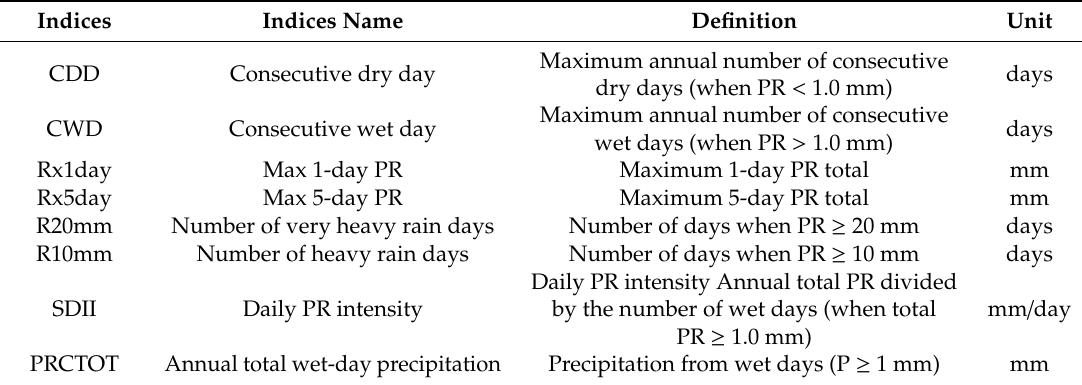
Table 2. List of used extreme precipitation